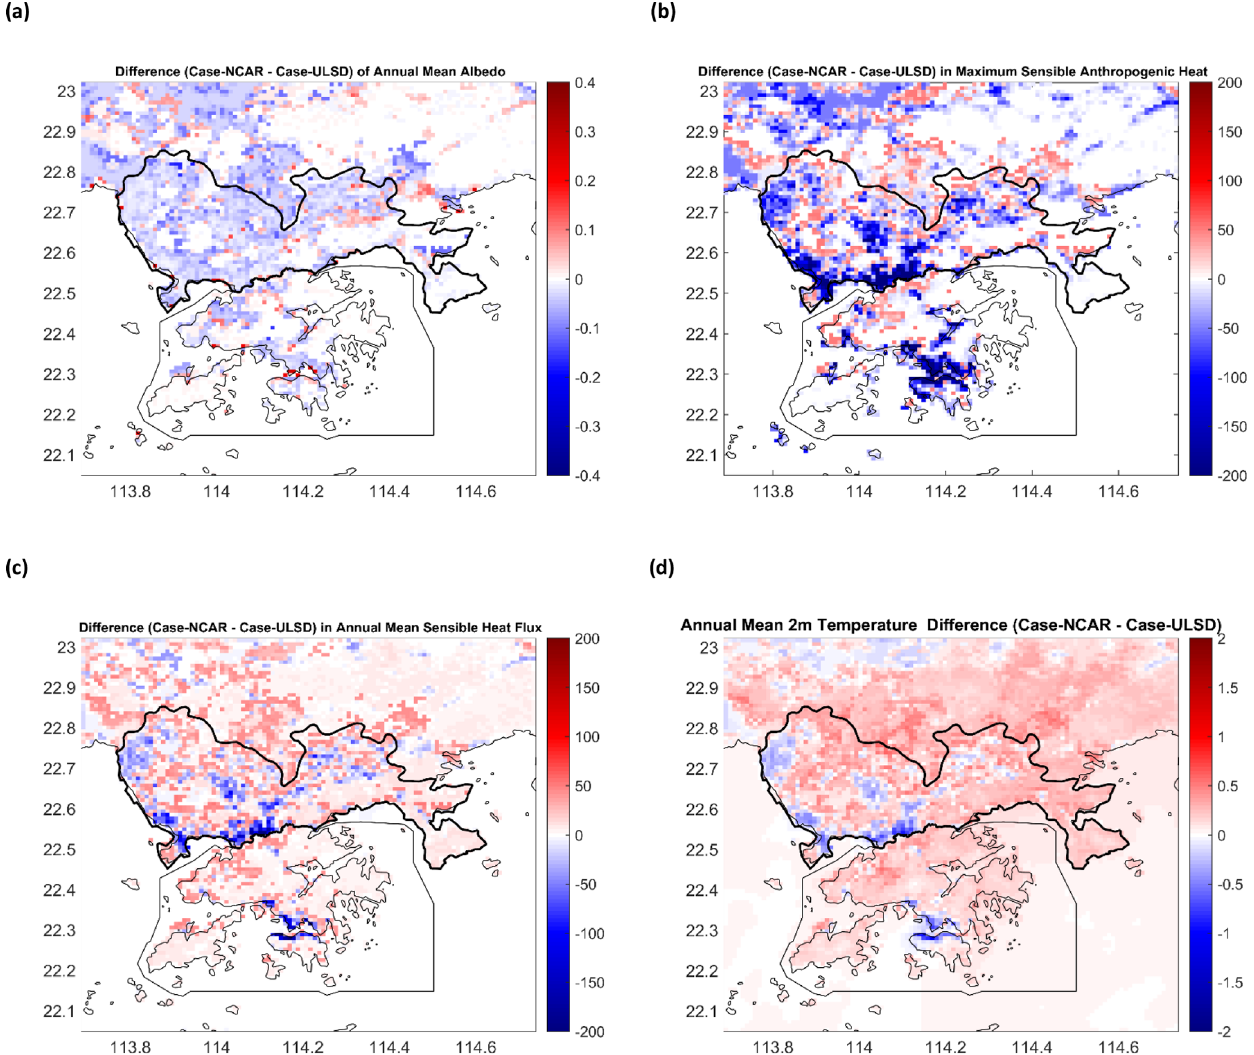
Figure 12. Differences (Case-NCAR − Case-ULSD) in the albedo (a) , the sensible anthropogenic heat (b) , the annual mean sensible heat (c) , and the annual mean 2m air temperature (d)